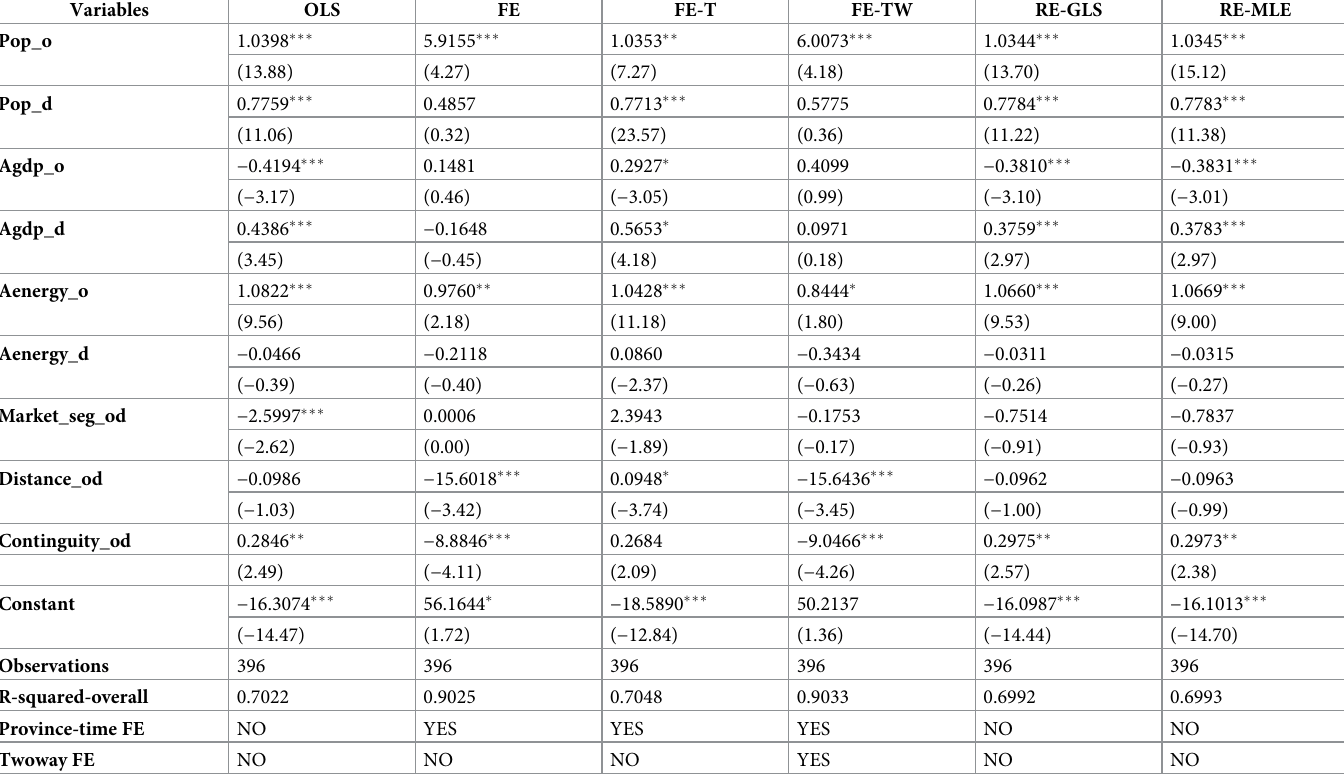
Table 7. The gravity estimated results using interprovincial embodied CO 2 flows between Central and Western China.